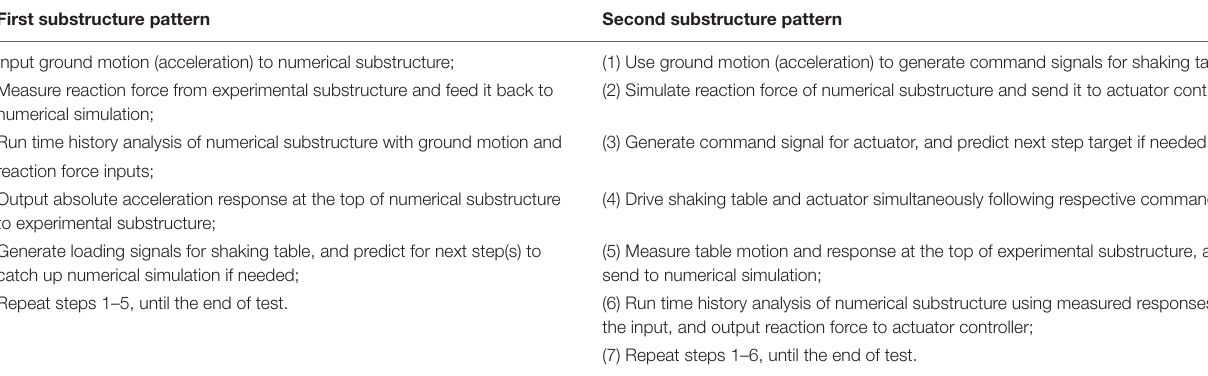
TABLE 2 | Test procedures of STST in different substructure pattern. First substructure pattern Second substructure